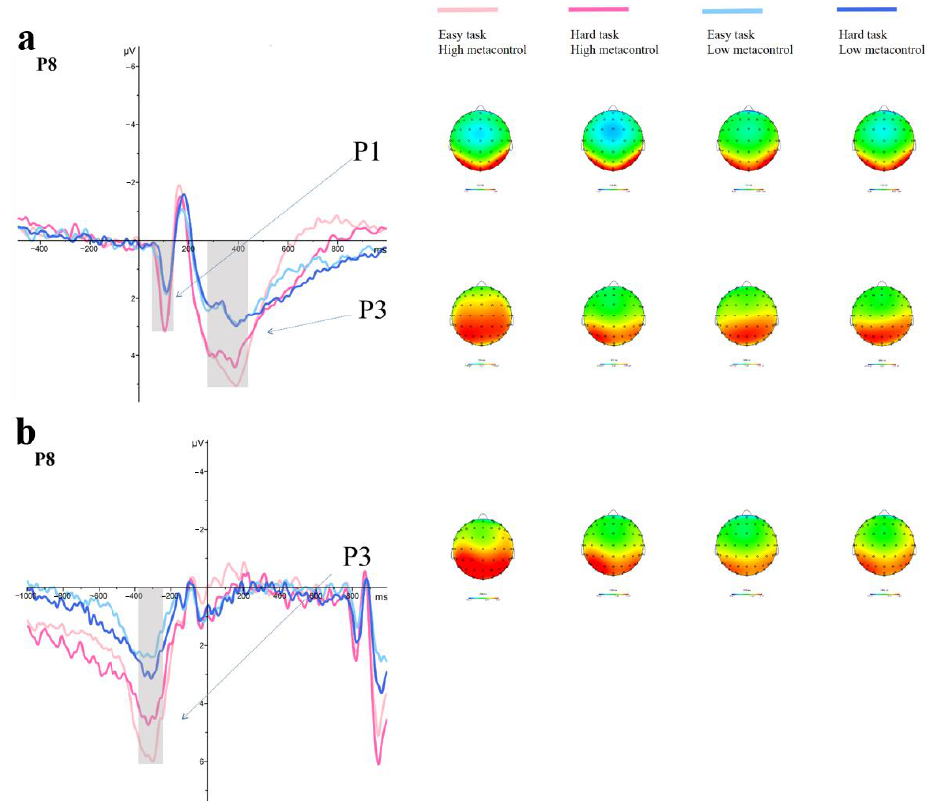
Figure 4. Stimulus-locked ( a ) and response-locked ( b ) grand-average waveforms from the P8 elec- Figure 4. Stimulus‑locked ( a ) and response‑locked ( b ) grand‑average waveforms from the P8 elec‑ trode and topographic maps for the metacontrol task. trode and topographic maps for the metacontrol